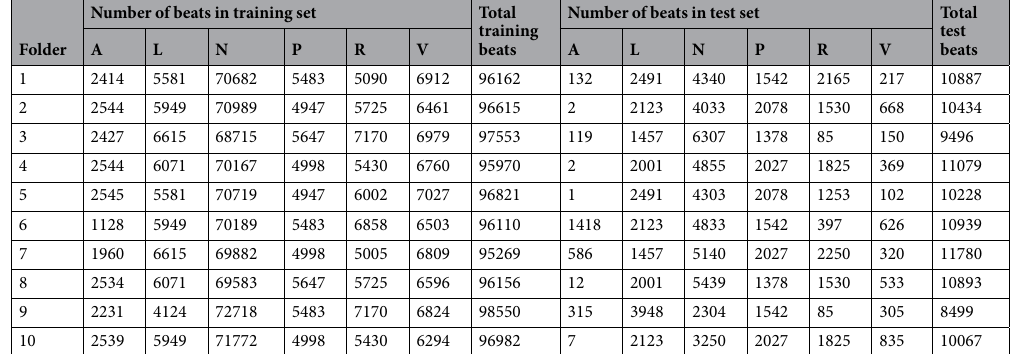
Table 2. Data profile for the record-based 10-fold cross validation scheme.